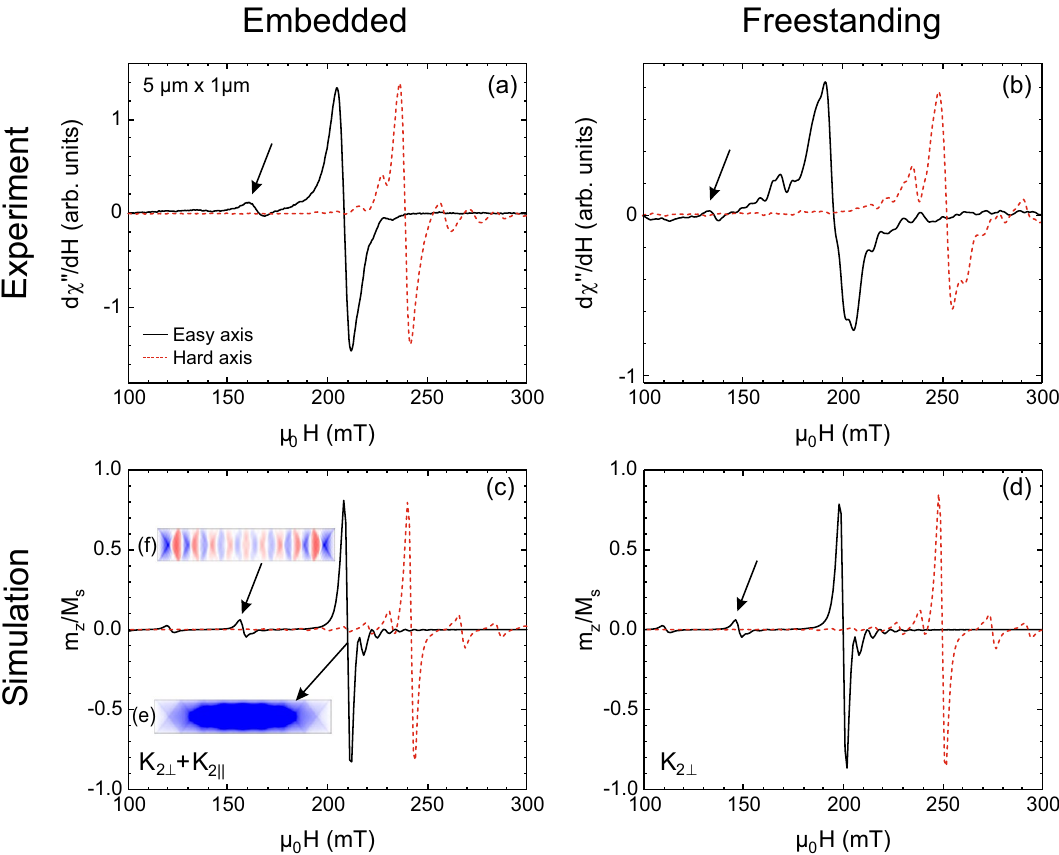
Figure 3. (Color online) FMR spectra observed at a frequency of 13.9 GHz, ( a ) for the A2 Fe 60 Al 40 ferromagnet surrounded by B2 Fe 60 Al 40 and ( b ) for the freestanding A2 Fe 60 Al 40 ferromagnet. ( c , d ) show the corresponding micromagnetic simulations of the embedded and freestanding sample, respectively. Measurements/ simulations with the external field along the magnetically easy (hard) axis are shown by black solid (red dotted) lines, respectively. The insets show snapshots of ( e ) the quasi uniform (center) mode and ( f ) a standing spin wave mode using a red-white-blue colour scale, where the magnitude of the transient magnetization z -component, ± m z ; white indicates m z = 0 and red (blue) regions possessing + (−) m z . Embedded structure Table 1. Comparison of the uniform resonance modes obtained from experiments and simulations for the embedded and freestanding structures for both easy and hard axis geometry.